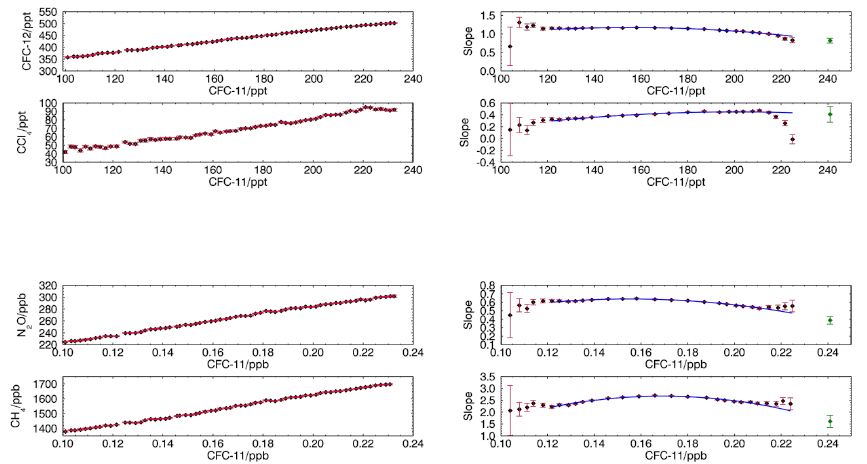
Figure B1 Correlations between the volume mixing ratios of CFC-12, CCl 4 , CH 4 , and N 2 O and CFC-11 for the data from the northern hemisphere during the stratospheric summer of 2006. Left panels: The mean correlation profile. Each point represents the mean of the VMR in a window of 2 ppt of CFC-11. The error on these points is the standard deviation of the data within each 2 ppt window. Right panels: The local slope of data in an 80 ppt of CFC-11 window. The error on the points is the fitting error of this fit. The blue line is a second degree polynomial fit to the local slopes. The green point is the extrapolated slope at the tropopause.